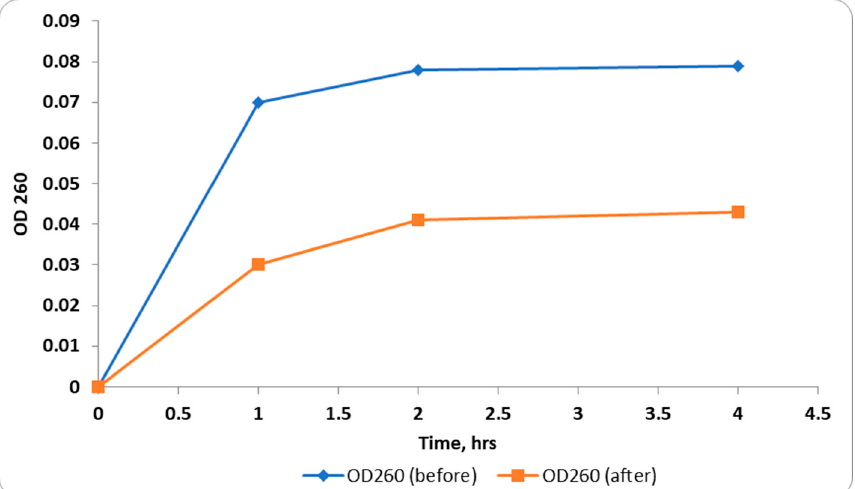
Figure 3. Release of 260 nm absorbing material from representative K. pneumoniae isolates before and after treatment with C. thouarsii extract (16 µg/mL).